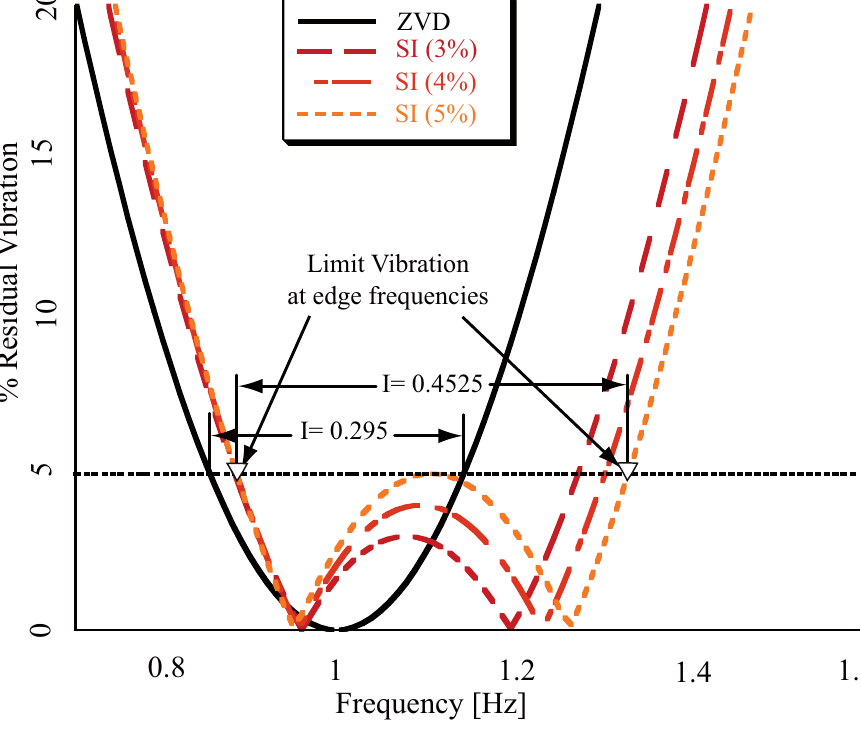
Figure 3. Robust input shapers sensitivity curves as a function of the vibration